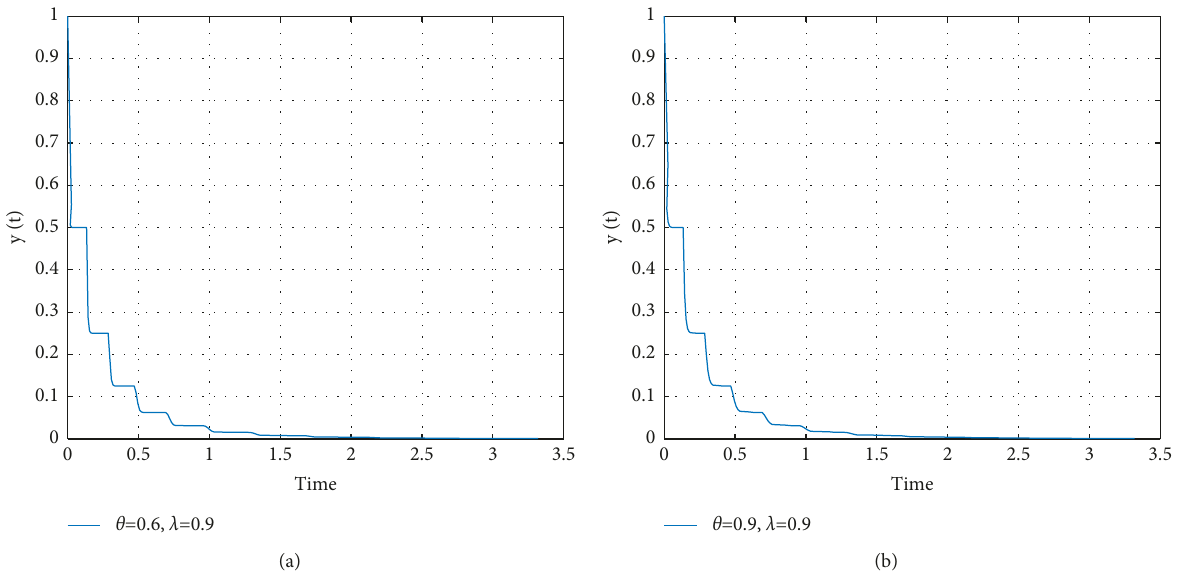
Figure 6: Numerical simulations of model (36) with ϑ � 0 . 6 (a) and ϑ � 0 . 9 (b), when λ � 0 .